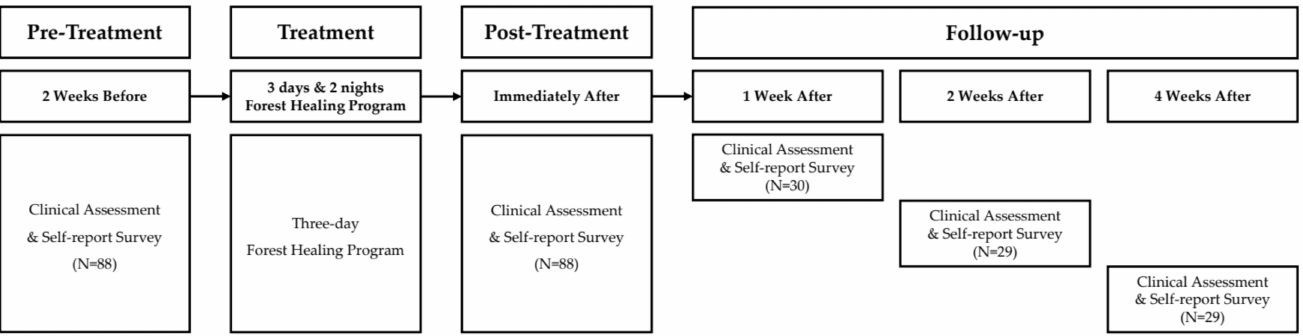
Figure 1. Schematic diagram of the research